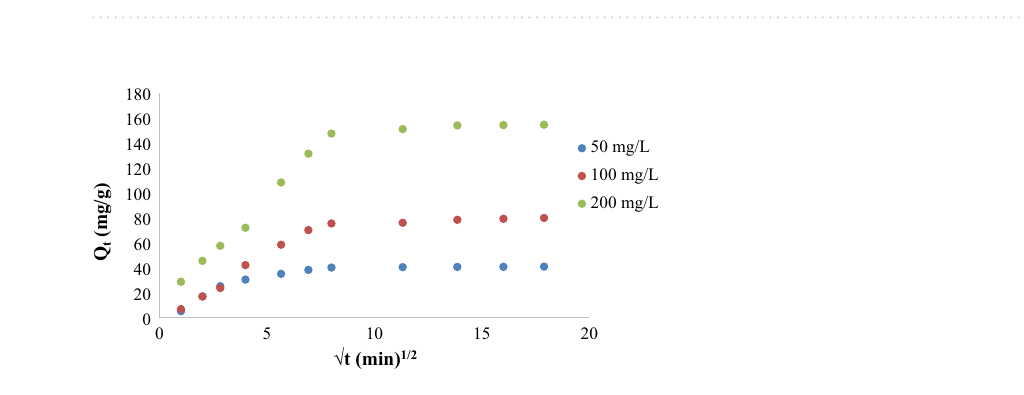
Figure 10. ( a ) Kinetic model of the 1st order and ( b ) Kinetic model of the 2nd order for KMnO 4 adsorption by Ox-FVESP.